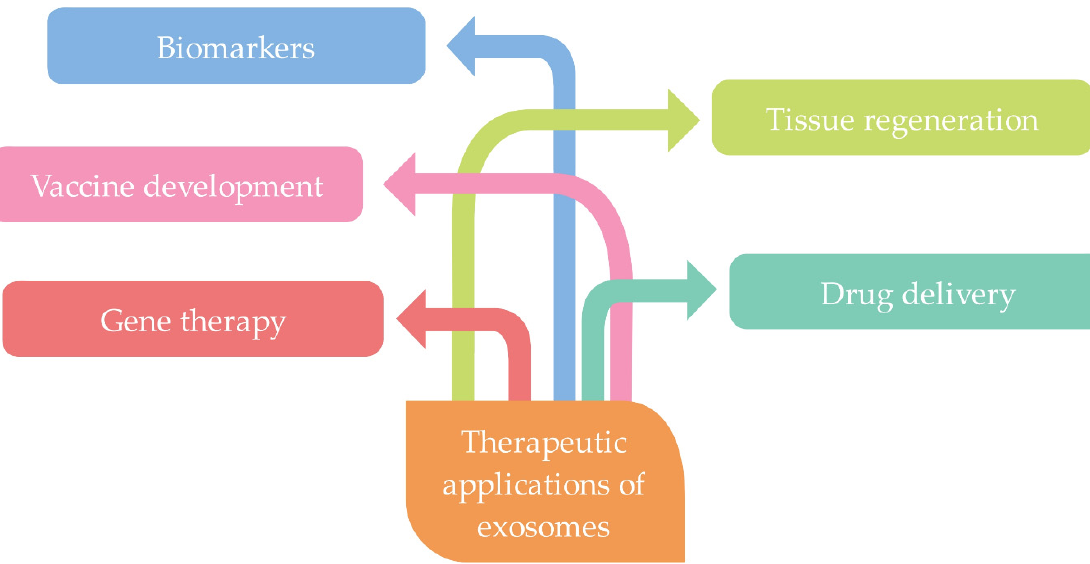
Figure 11. Schematic representation of various therapeutic applications (e.g., gene therapy, vaccine development, tissue regeneration, drug delivery, and as biomarkers in the diagnosis and therapy) of exosomes (summarized from [15,21]).